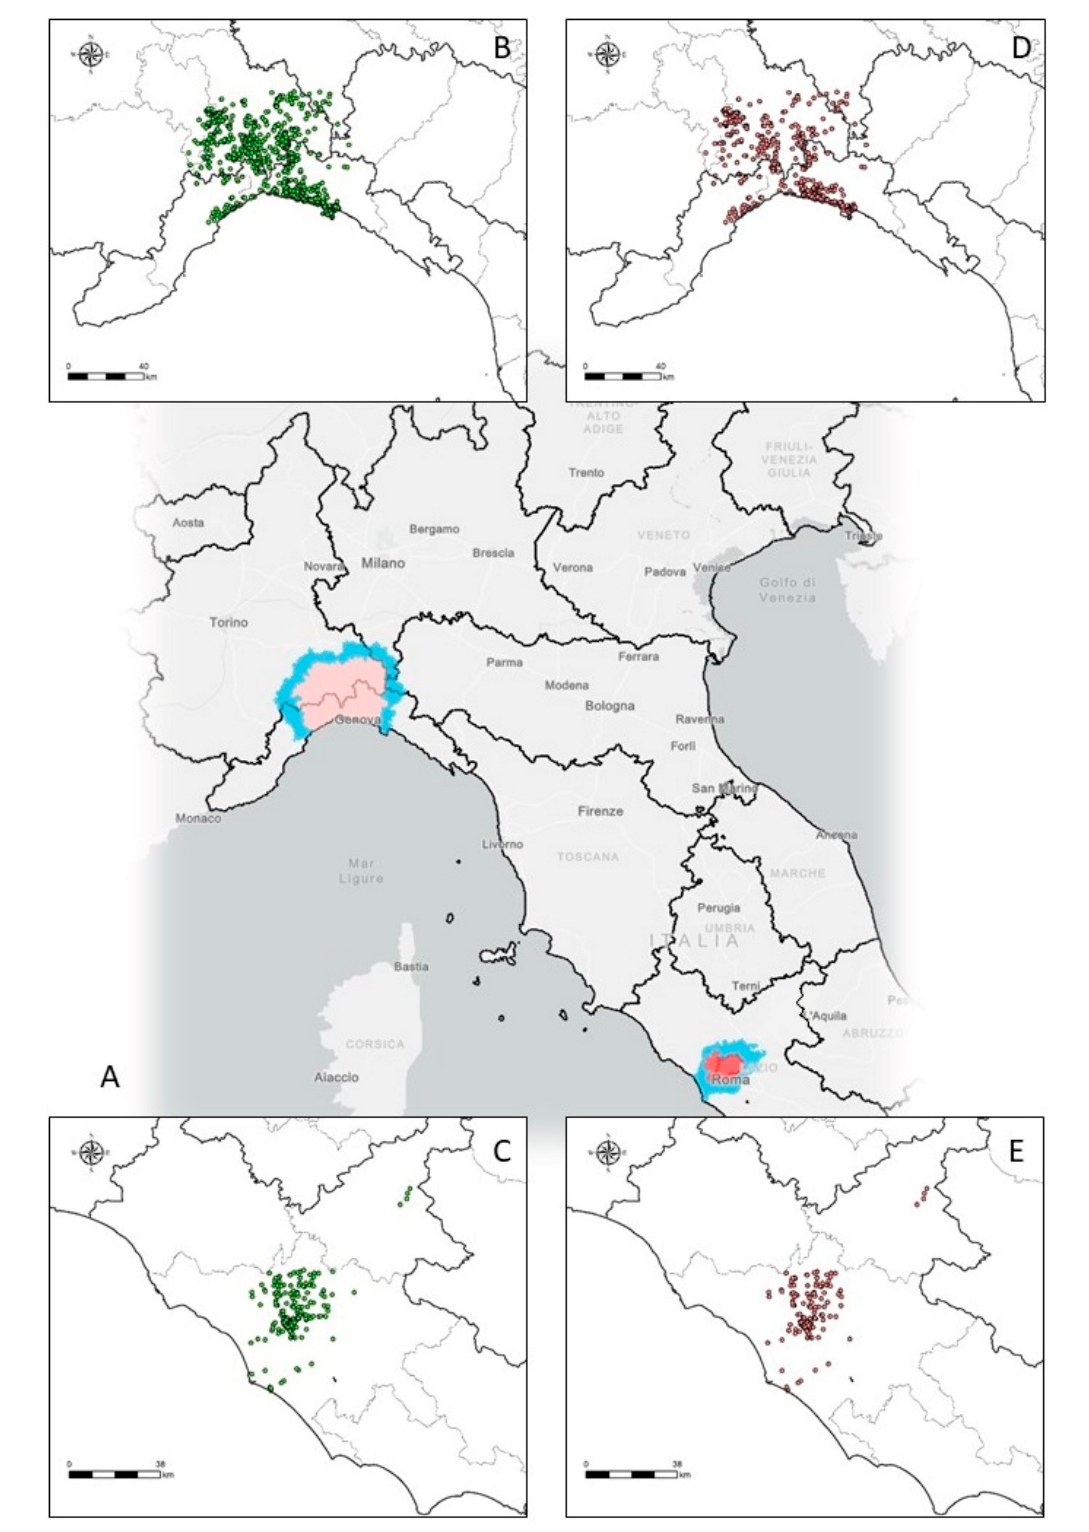
Figure 1. African swine fever epidemiological situation in Italy in the two infected and surveillance areas subject to level I (blue area), II (pink area), and III (red area) restrictions ( A ); wild boar samples from Piedmont (PL) area ( B ) and from Lazio (LA) area ( C ) and those from fresh carcasses in PL ( D ) and in LA ( E ). Data and associated information were collected by SIMAN.